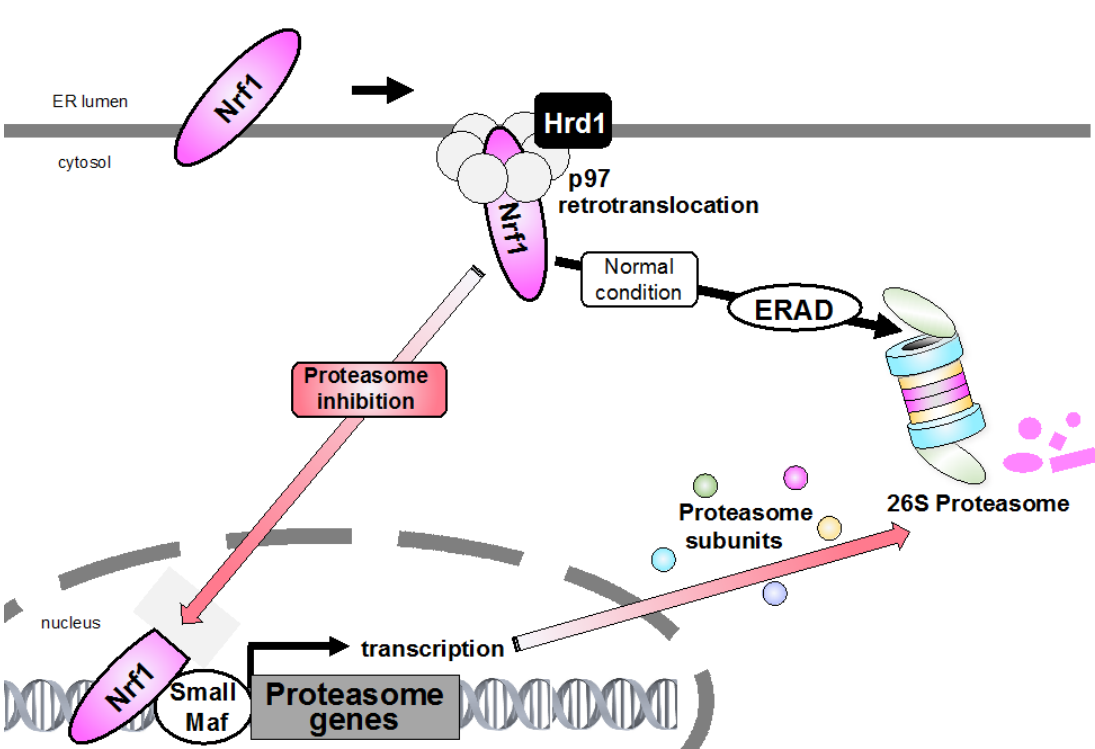
Figure 1. Bounce-back response. Endoplasmic reticulum (ER)-resident nuclear factor erythroid-derived 2-related factor 1 (Nrf1) is constantly degraded via ER-associated degradation (ERAD) machinery under normal conditions. During proteasome inhibition, accumulated Nrf1 translocates from the ER into the nucleus and promotes the expression of targets including proteasome subunit genes. This negative feedback mechanism of proteasome gene induction is called “bounce-back